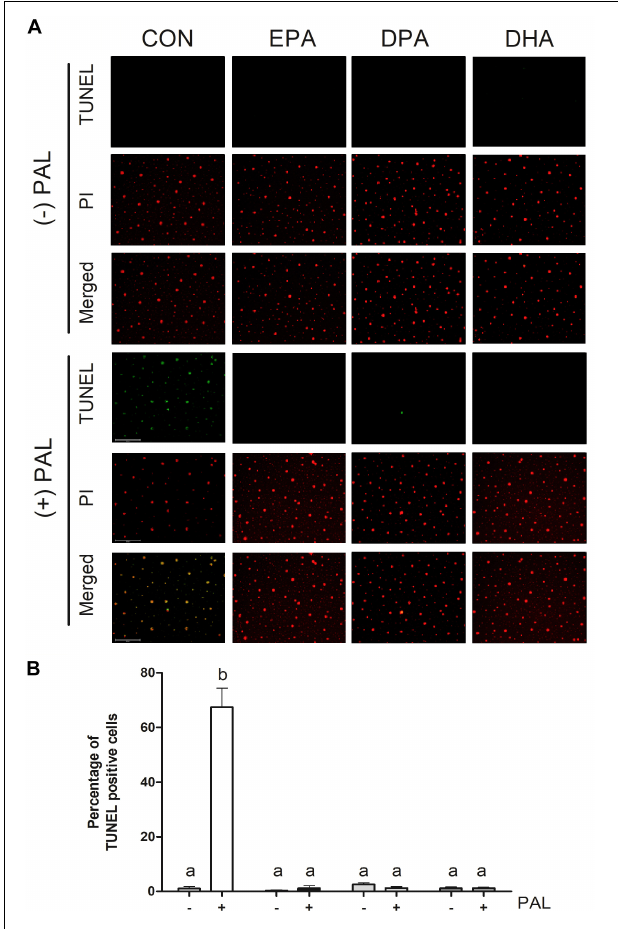
FIGURE 2 | EPA, DPA, and DHA attenuate PAL-induced increases in DNA fragmentation characteristic of apoptosis. Representative images of myoblast TUNEL staining 16 h following treatment with 500 µ M PAL and/or 50 µ M EPA, DPA or DHA (A) . Percentage of TUNEL positive cells relative to total number of cells in the field (B) . Treatments that do not share letters are considered statistically significant ( p < 0.05; myoblasts were cultured and harvested independently to generate a total sample size of 3 biological replicates). Scale bar represents 125 µ m. Values are presented as mean ±